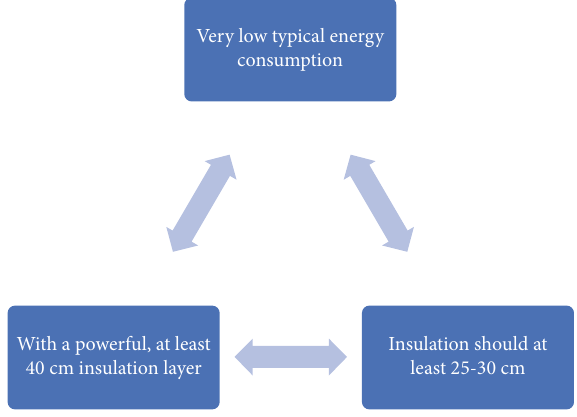
Figure 1: Powerful heating